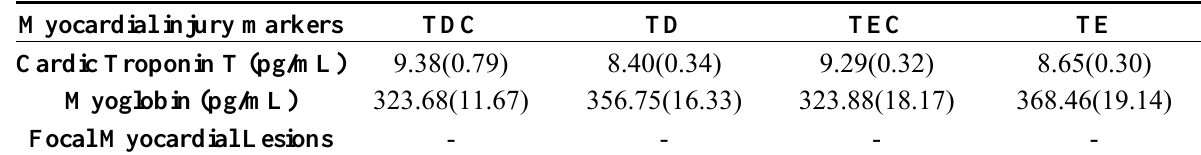
Table 2. Results of plasma Mb and cTnT levels and cases of hearts with lesions. (mean (SE), n = 6 in each